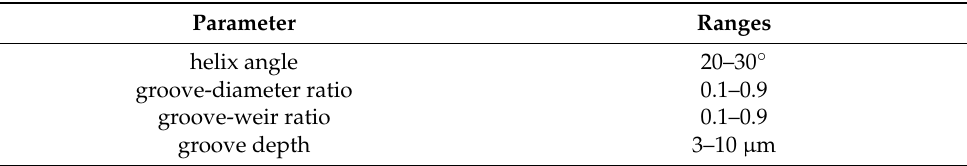
Figure 4. Variation curve of average vapor phase volume fraction with mass transfer coefficient.